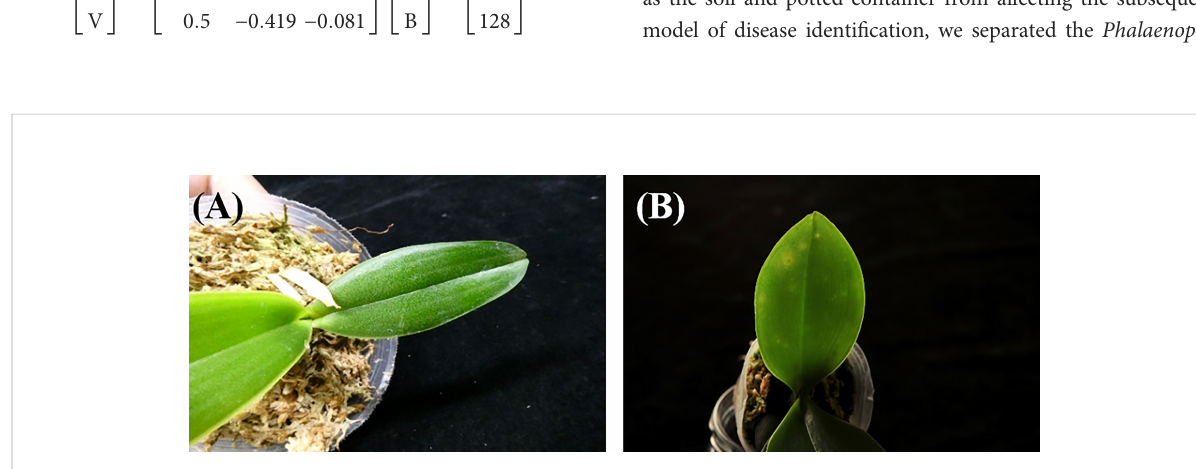
FIGURE 3 The bright (A) and dark (B) orchid